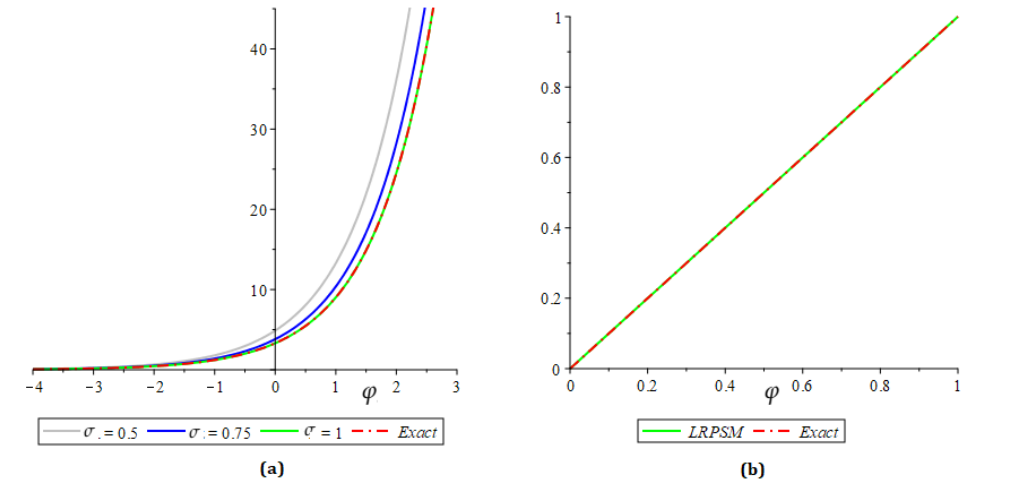
Figure 4. Exact and LRPSM solutions for ( a ) ρ ( ϕ , ξ , t ) and ( b ) p ( ϕ , ξ , t ) at distinct values of σ at ξ and t =